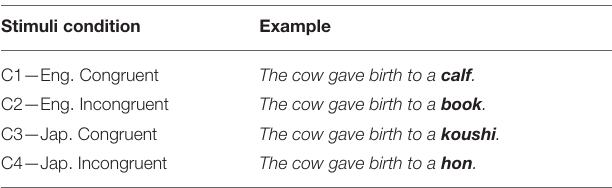
TABLE 1 | Different conditions of the stimuli sentences used in our experiment with an example. Stimuli